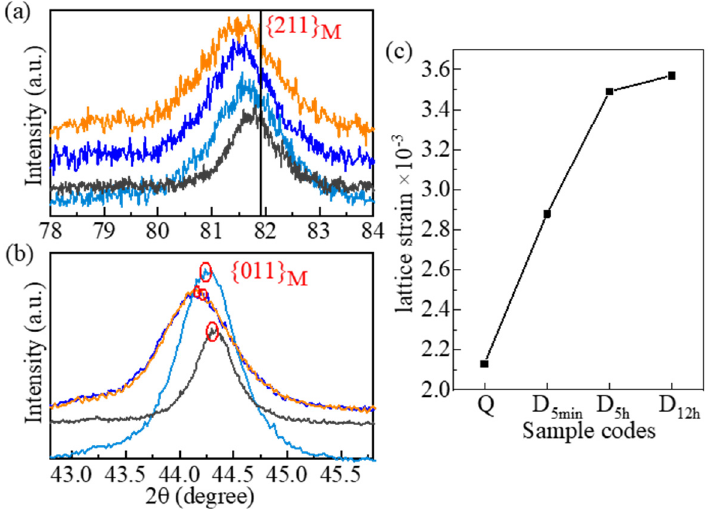
5min, D 5h , and D 12h . Figure 3. XRD pattern of Q, D